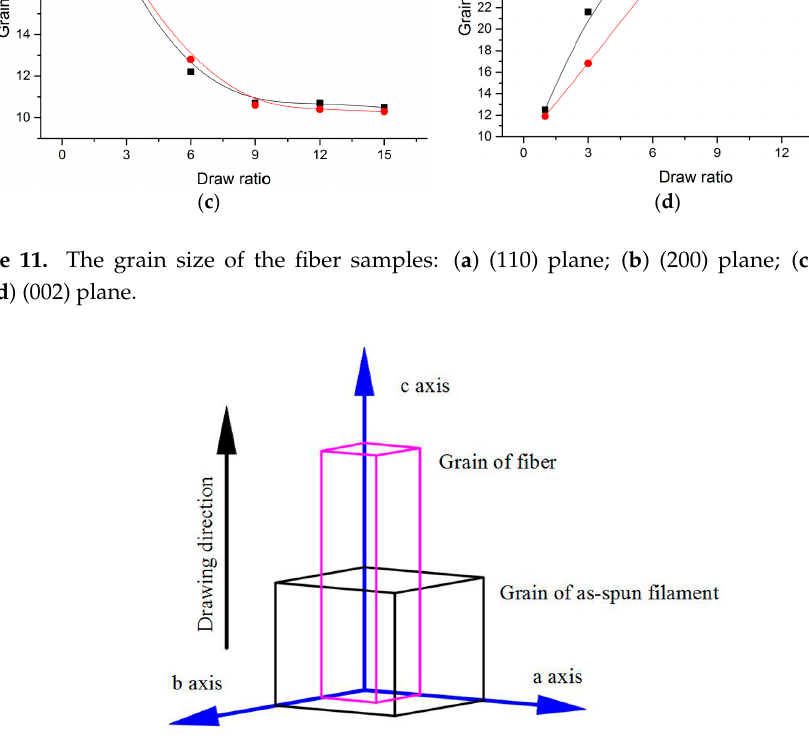
Figure 12. Deformation of the crystal structure during hot drawing process.